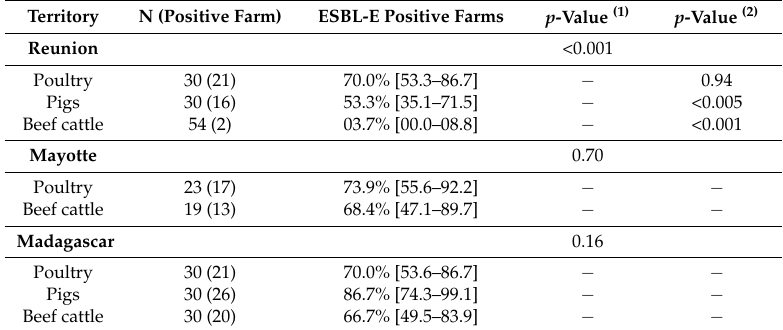
Table 1. Prevalence of ESBL-E in livestock production farms of Reunion, Mayotte and Madagascar,